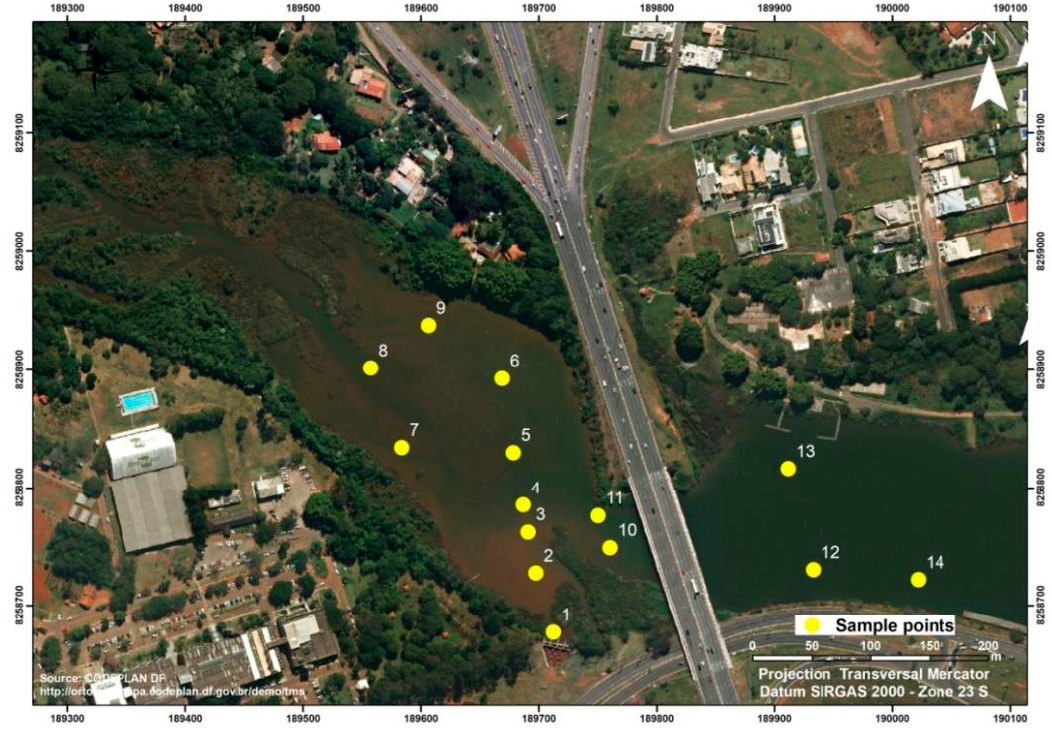
Figure 3. Location map of the inlet area between the Bananal River and the Parano á reservoir highlighting the in situ data sample